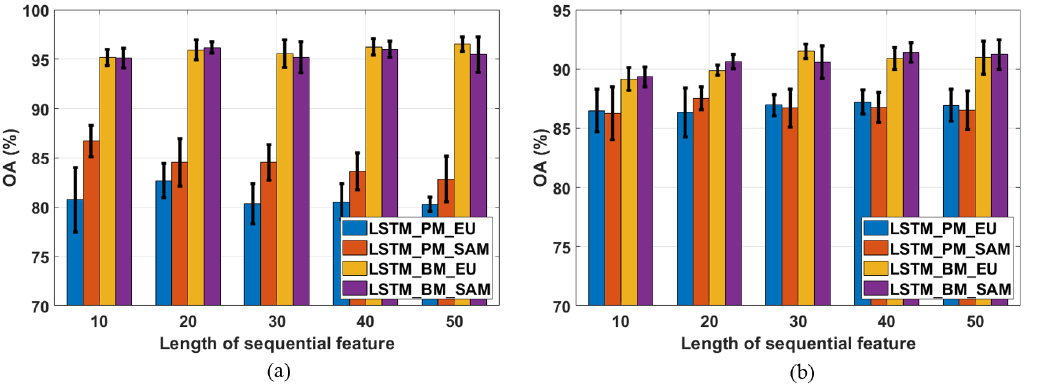
Figure 6. Analysis of different sequential feature lengths. ( a ) OAs based on the Pavia University image data; and ( b ) OAs based on the Salinas image